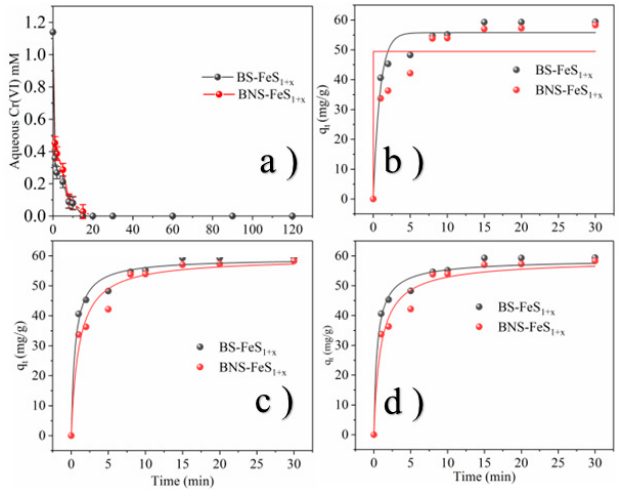
Figure 3. Kinetics of removal of Cr(VI) by biosynthesis of FeS 1+x . ( a ): the amount of Cr(VI) removed by BS-FeS 1+x and BNS-FeS 1+x ; ( b ): pseudo-first-order kinetic; ( c ): pseudo-secondary kinetic model fitting of BS-FeS 1+x and BNS-FeS 1+x removal Cr(VI); ( d ): adsorption kinetic models of Cr(VI). Reaction conditions: FeS 1+x dosage concentration was 11.4 mM; Cr(VI) dosage concentration was 1.14 mM; initial pH was 5.0; reaction time was 2 h; and speed was 200 rpm. BS-FeS 1+x : biosynthesis of iron sulfides containing SRB. BNS-FeS 1+x : biosynthesis of iron sulfide dry particles without SRB. Data were plotted as means of duplicates. and the error bars indicate the standard deviation. Table 1. Kinetic constants for the removal and adsorption of Cr(VI) using biosynthesis of FeS 1+ x . Pseudo-Frist-Order Pseudo-Secondary Experimen General-order Models Kinetic Kinetic t Data